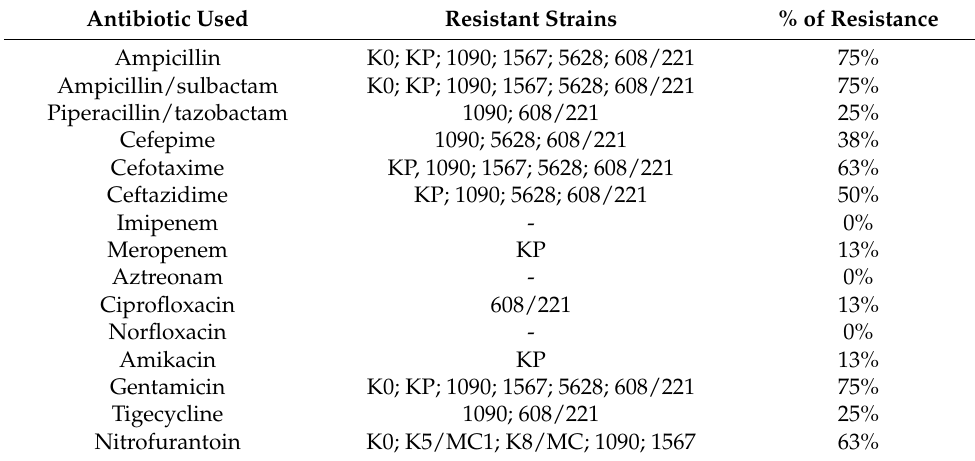
Table 1. Antibiotic susceptibility of P. mirabilis strains.